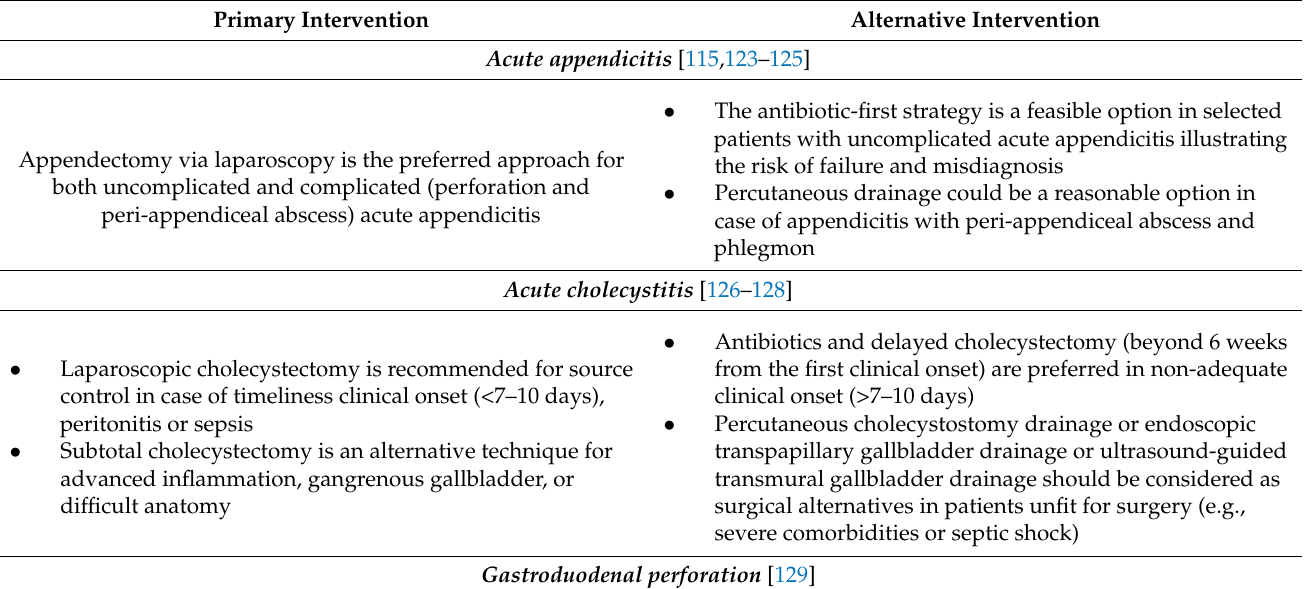
Table 2. Source control strategies for most common intra-abdominal infection